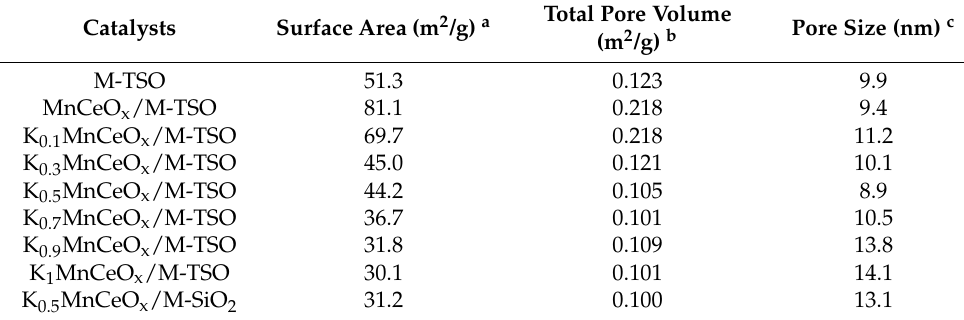
Figure 3. Nitrogen adsorption-desorption isotherms ( A ) and pore size distributions ( B ) of prepared catalysts ( a : M-TSO; b : MnCeO x /M-TSO; c : K 0.1 MnCeO x /M-TSO; d : K 0.3 MnCeO x /M-TSO; e : K 0.5 MnCeO x /M-TSO; f : K 0.7 MnCeO x /M-TSO; g : K 0.9 MnCeO x /M-TSO; h : K 1 MnCeO x /M-TSO; i : K 0.5 MnCeO x /M-SiO 2 ). Table 2. Textural properties of prepared catalysts.